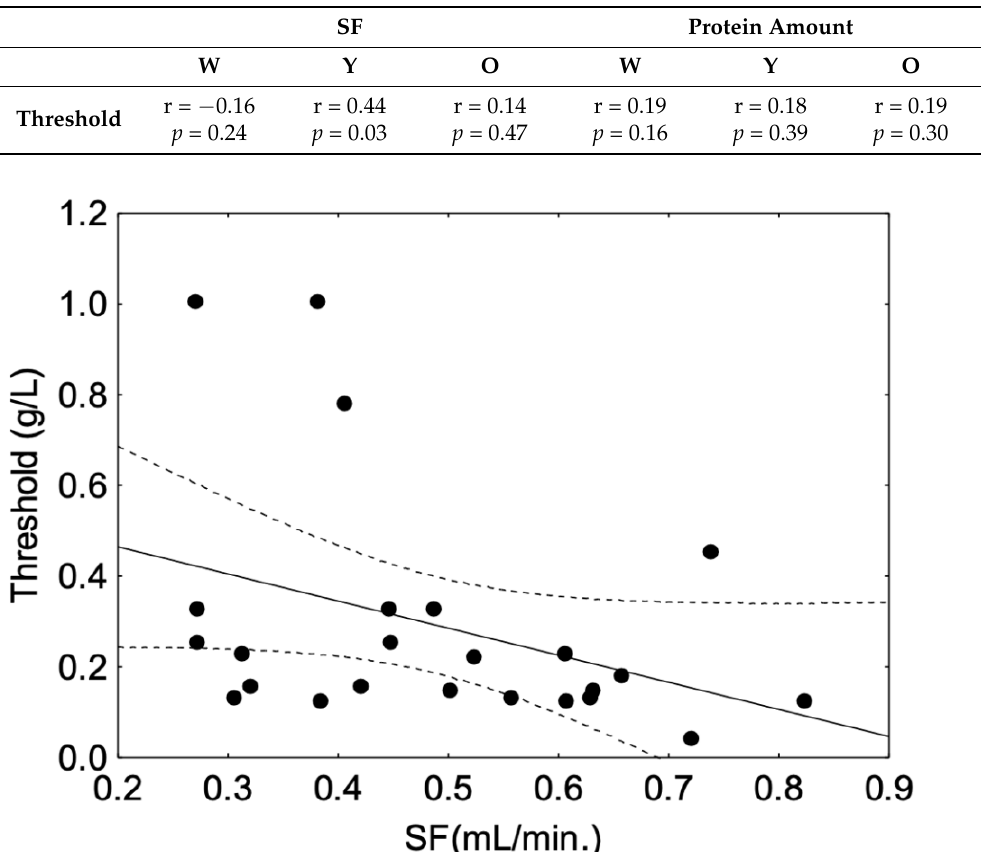
Figure 4. Spearman correlation between astringency threshold and whole salivary flow (SF) observed in the group of young panellists. The plain line corresponds to fitted data. The dotted line corresponds to the confidence interval at 95%. The black dot symbols correspond to individual data points.